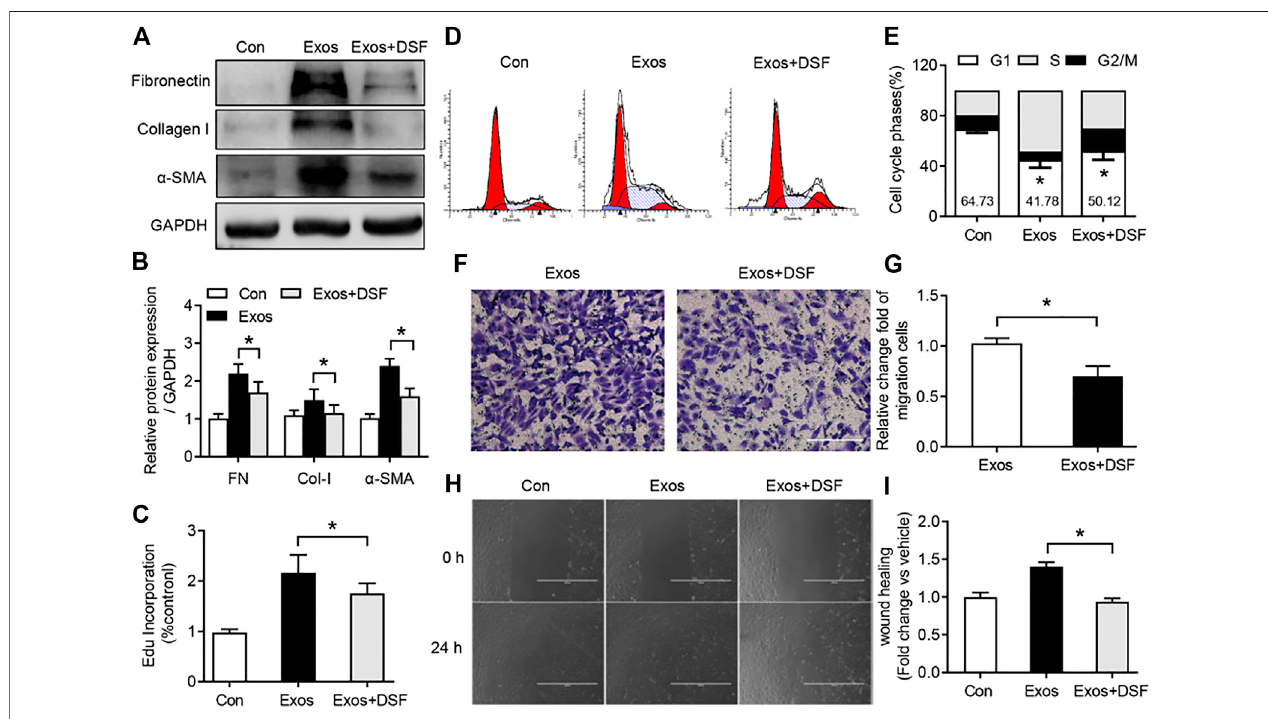
FIGURE 5 | DSF signi fi cantly reduced fi broblast activation and proliferation after BMDM exosome treatment. NIH/3T3 fi broblasts were cultured and treated with macrophage-derived exosomes. Cells were pretreated with DSF (5 μ M) or DMSO (0.01%) for 2 h. (A,B) Western blot (A) and quantitative (B) analyses of FN, Col-I, and α -SMA in fi broblast from control, exosomes, and exosomes in the presence of DSF. (C) Quantitative analysis of EdU incorporation in fi broblast from control, exosomes, and exosomes in the presence of DSF. (D,E) FACS (D) and quantitative (E) analysis of cell cycle in fi broblast from control, exosomes, and exosomes in the presence of DSF. (F,G) The picture (F) and quantitative analysis (G) of the cell migration in fi broblast from control, exosomes, and exosomes in the presence of DSF. Scale bar = 20 μ m. (H,I) The picture (H) and quantitative analysis (I) of the cell wound scratch assay in fi broblast from control, exosomes, and exosomes in the presence of DSF. Scale bar = 20 μ m. Data are presented as the mean ± SEM ( n = 3) (B,C,E,G,I) . * p <